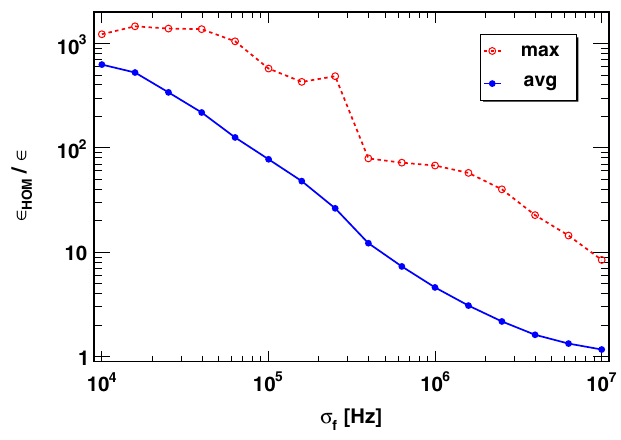
FIG. 11. Average (solid, blue) and maximum (dashed, red) longitudinal phase space increase as a function of the HOM frequency spread at the 4th machine line. Losses occur in the i ¼ 1408 : 8 MHz , h I i ¼ =(cid:6) > 100 . Settings: h f case of (cid:6) b HOM HOM 40 mA , N ¼ 100 , see Table VI.